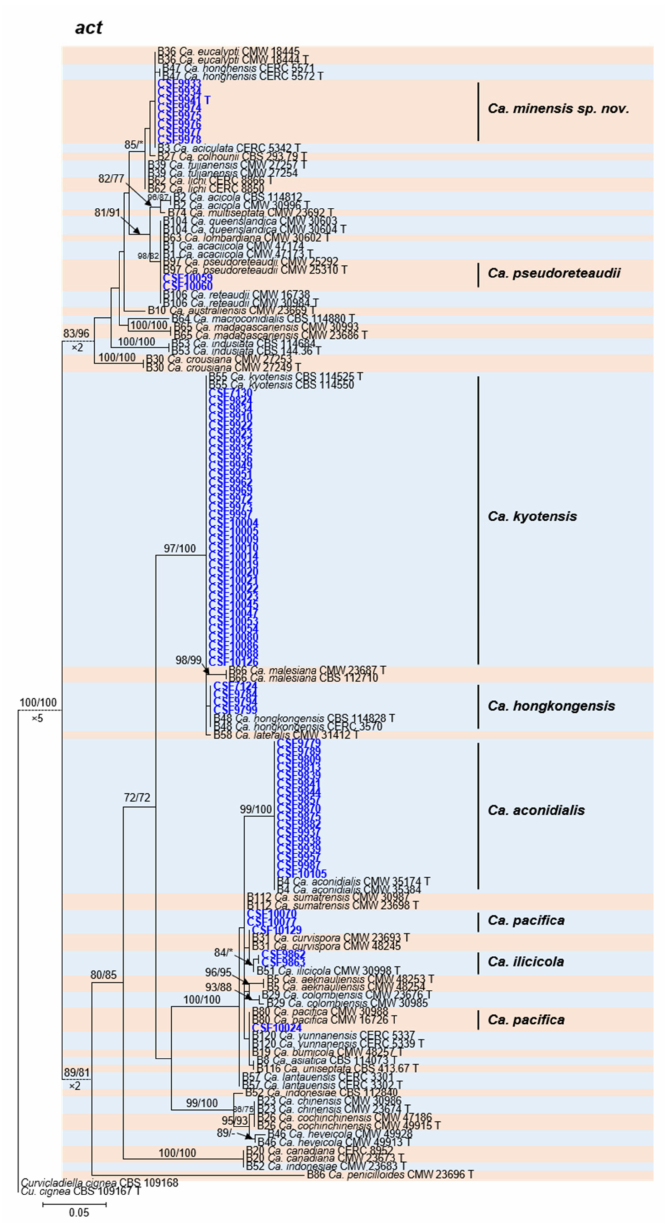
Figure A1. Phylogenetic tree of Calonectria species based on maximum likelihood (ML) analyses of act gene sequences. Bootstrap value ≥ 70% for ML and MP analyses are presented at the branches. Bootstrap values lower than 70% are marked with “*”, and absent analyses values are marked with “-”. Ex-type isolates are marked with “T”. Isolates sequenced in this study are highlighted in blue and bold type. The “B” species codes are consistent with the recently published results in Liu